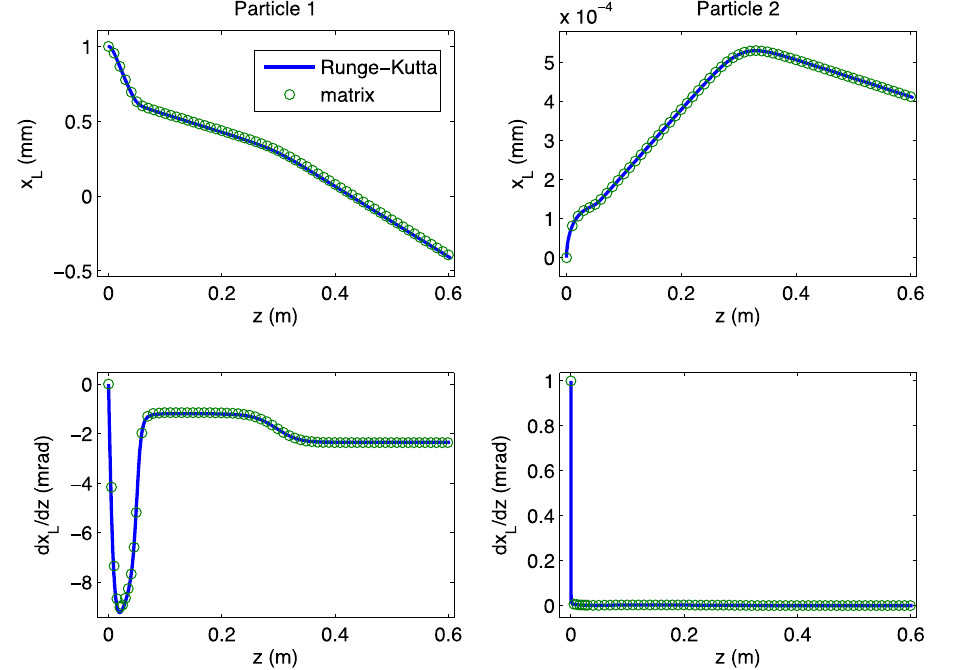
FIG. 2. Comparison of Runge-Kutta integration (blue) and the tracking using the transfer matrix (green) through the DC gun and solenoid fields.